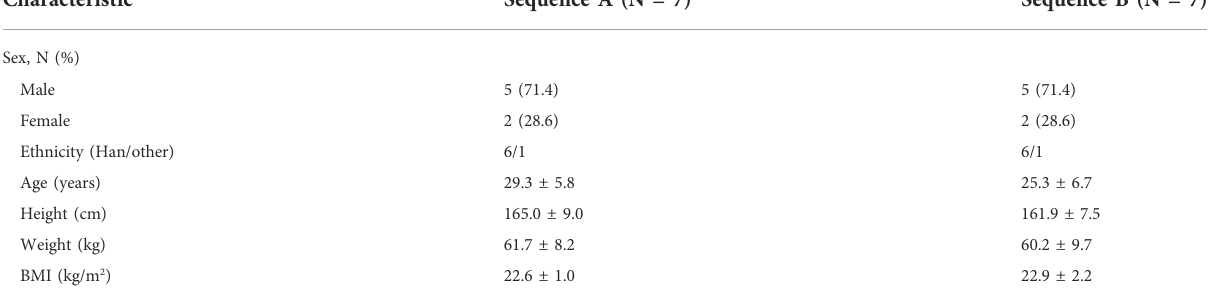
TABLE 1 Demographics and baseline characteristics of subjects.